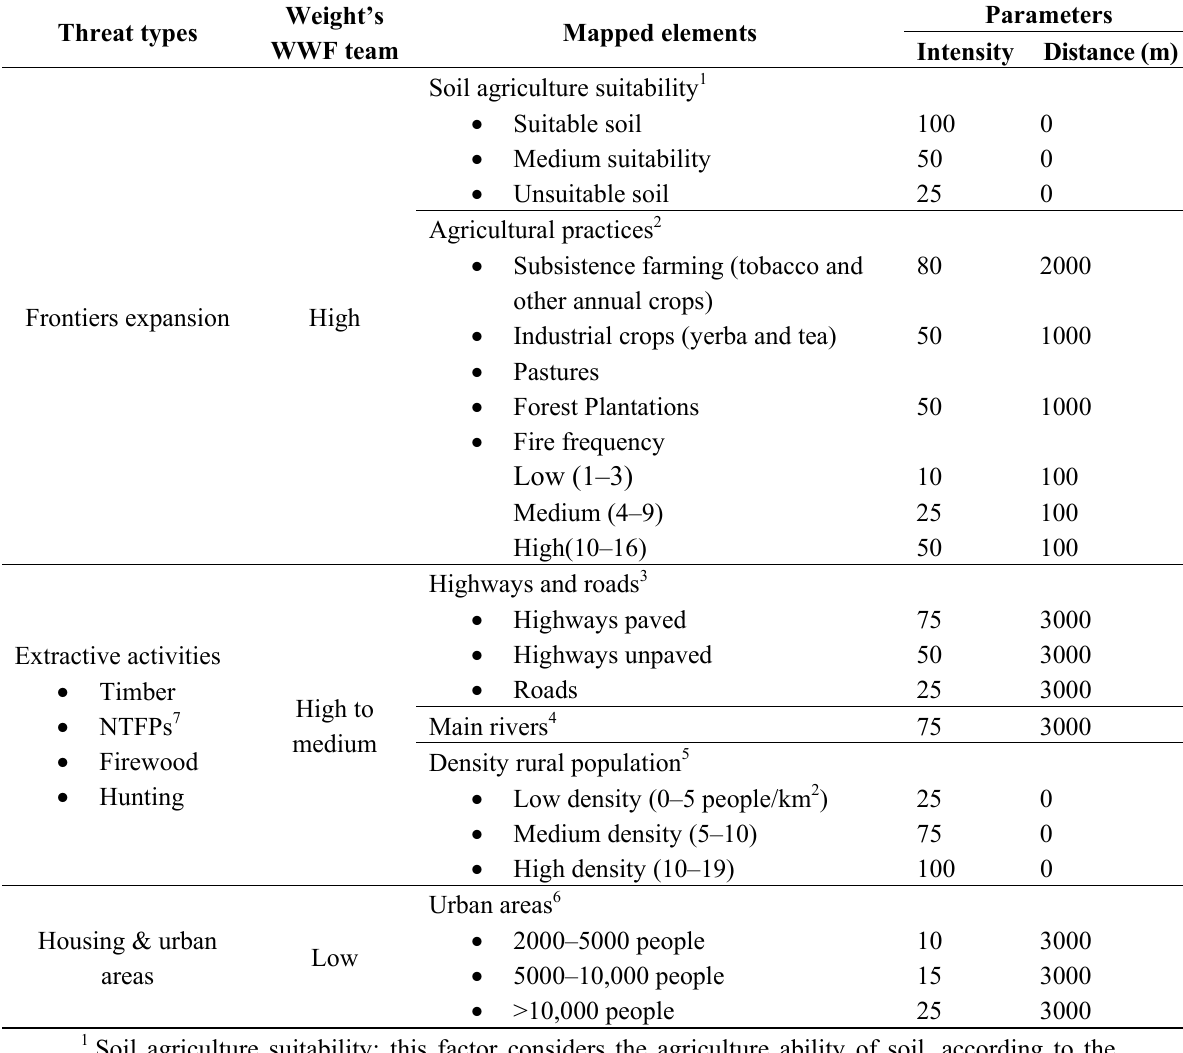
Table 1. Elements and parameters of the threat surface based on WWF threat types and associated